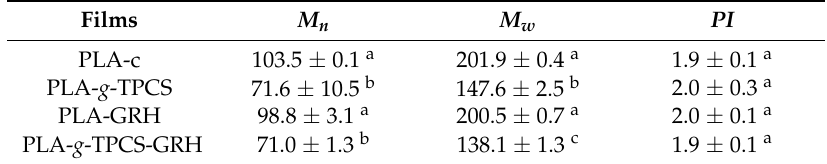
Table 3. M n , M w , and PI of PLA-c and the PLA portion of the various films